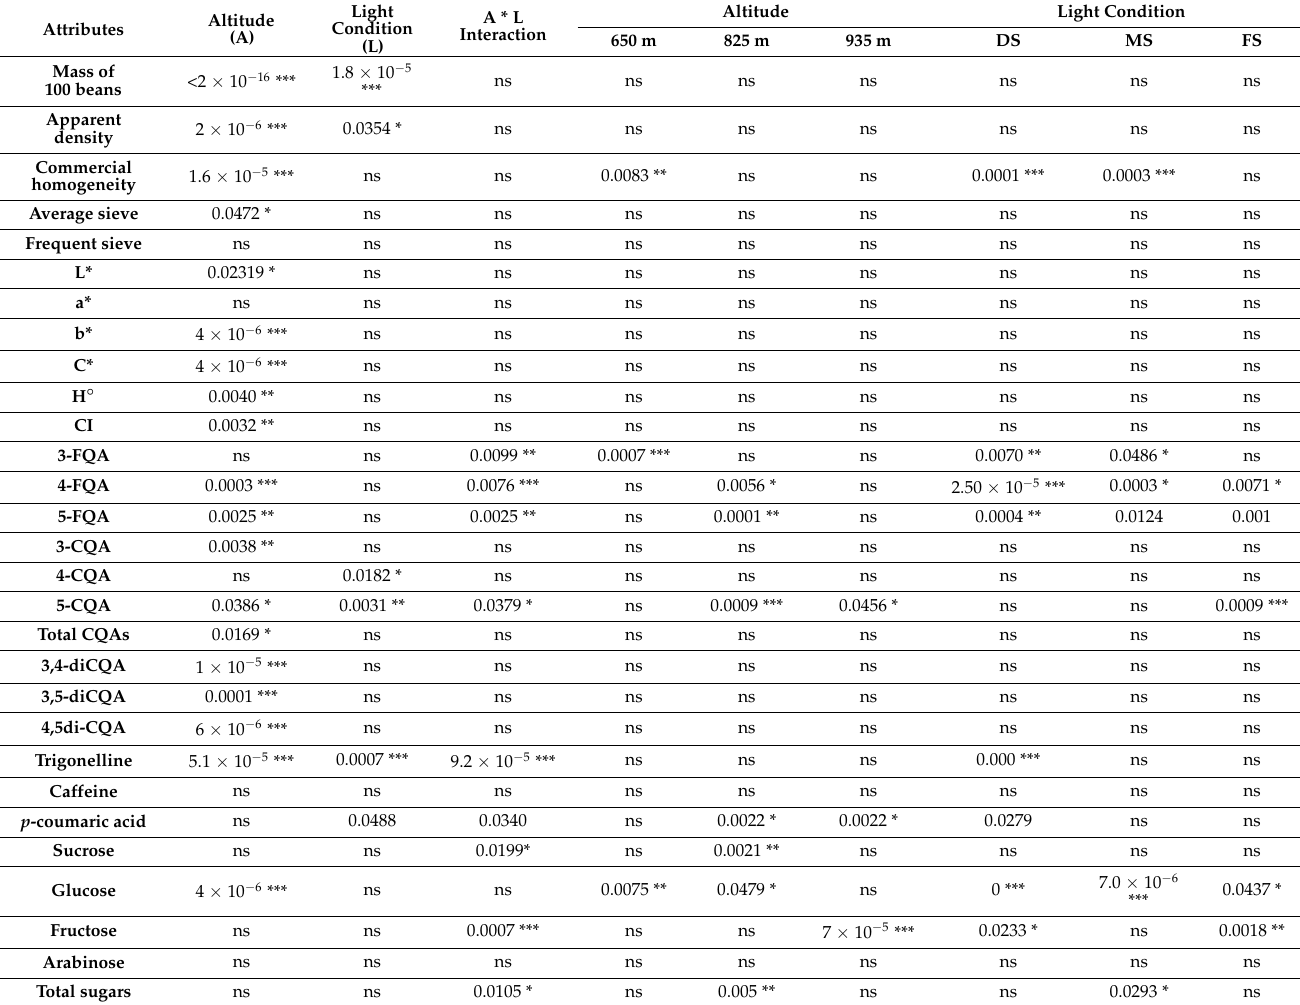
Table 1. ANOVA results for altitude and light condition effects and their interaction on the attributes mass of 100 green coffee beans, and bean apparent density, colour lightness (L*), the contributions of red or green (a*), and blue or yellow (b*), as well as the calculated parameters of Chroma (C*), Hue angle (H ◦ ), and colour index (CI), trigonelline, caffeine, p -coumaric acid, monocaffeoylquinic acids (3-CQA, 4-CQA, 5-CQA), feruloylquinic acids (4-FQA, 5-FQA), and dicaffeoylquinic acids (3,4-diCQA, 3,5-diCQA, 4,5-diCQA), and soluble sugars (sucrose, glucose, fructose, arabinose, total sugars), obtained of green coffee beans obtained under three light exposure conditions (deep shade, DS; moderate shade, MS; full Sun, FS) and three altitudes (650 m, 825 m and 935